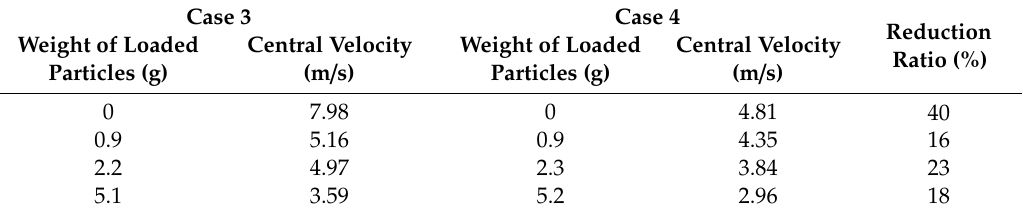
Table 7. Central velocity comparison of case 3 (conventional cone) and case 4 (NURBS cone).